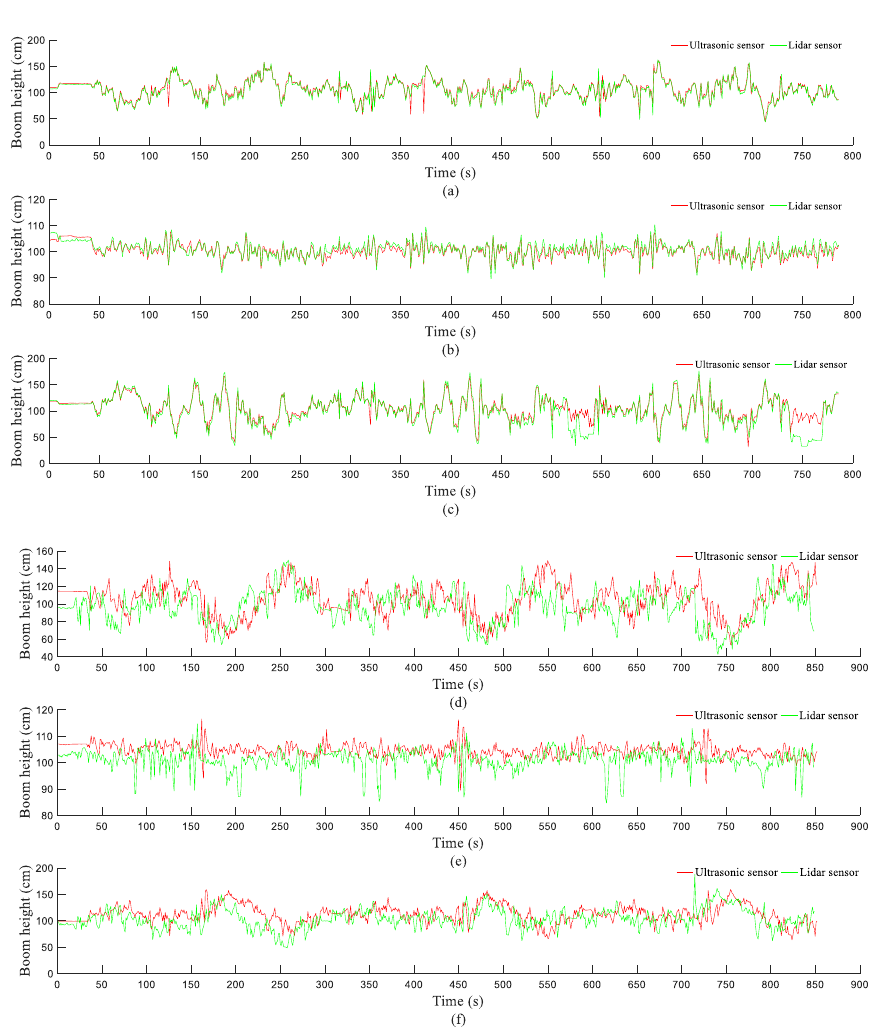
Figure 13. Results of the boom height detection experiment: where ( a – c ) corresponds to the H b changes in the left, middle, and right sections of the boom for rotary-tilled field and ( d – f ) corresponds to the H b changes in the left, middle, and right sections of the boom for the WS field.